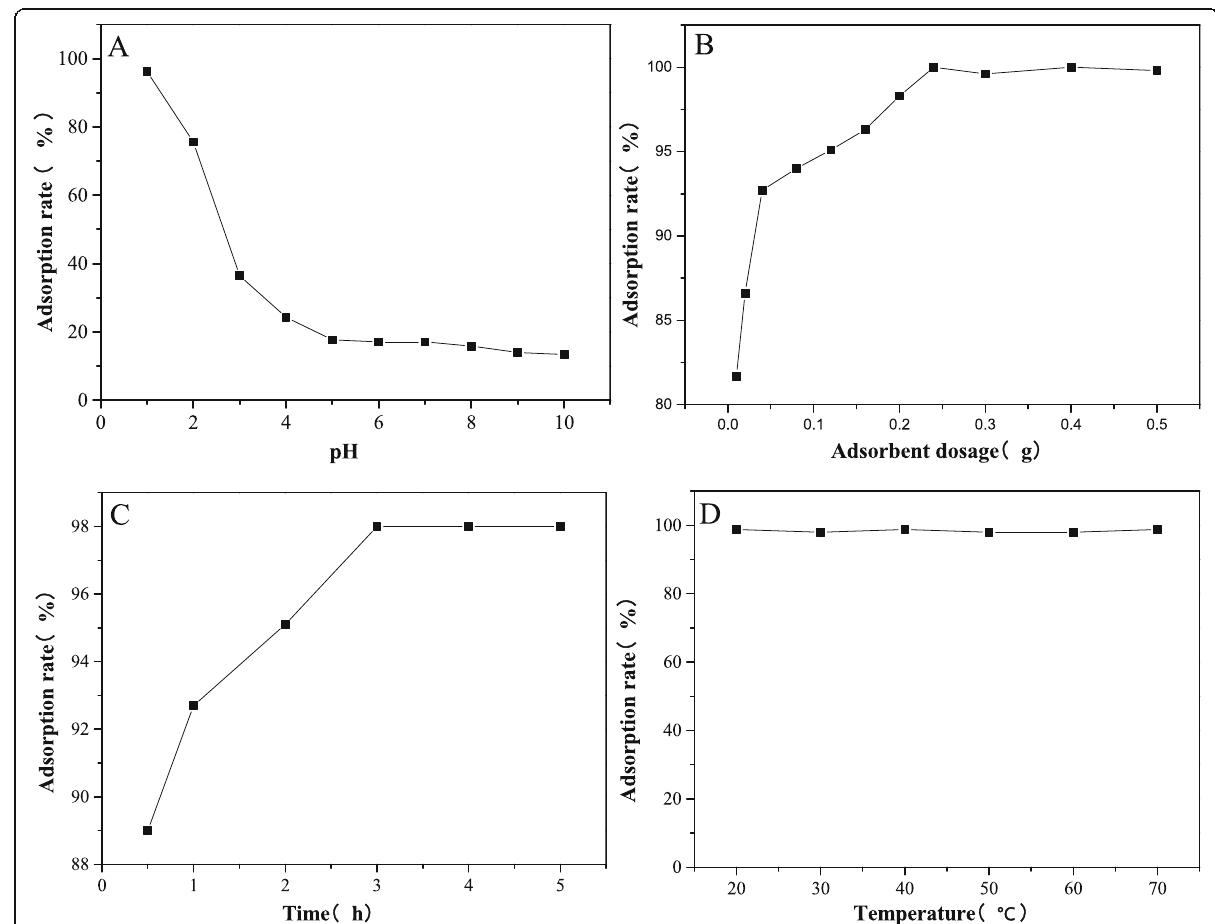
Fig. 3 Effect of pH ( a ), adsorbent dosage ( b ), time ( c ), and temperature ( d ) on the amaranth adsorption. (amaranth 2 mg L − 1 , oscillation speed 200